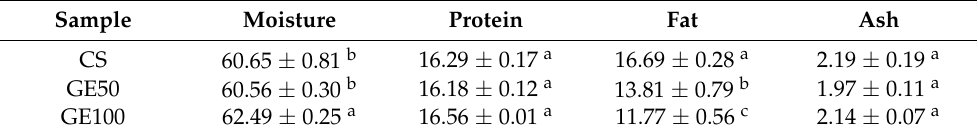
Table 1. Chemical composition of Frankfurt-type sausage formulates replacing pork backfat with gelled emulsion elaborated with peanut flour and flaxseed oil. Sample Moisture Protein Fat CS